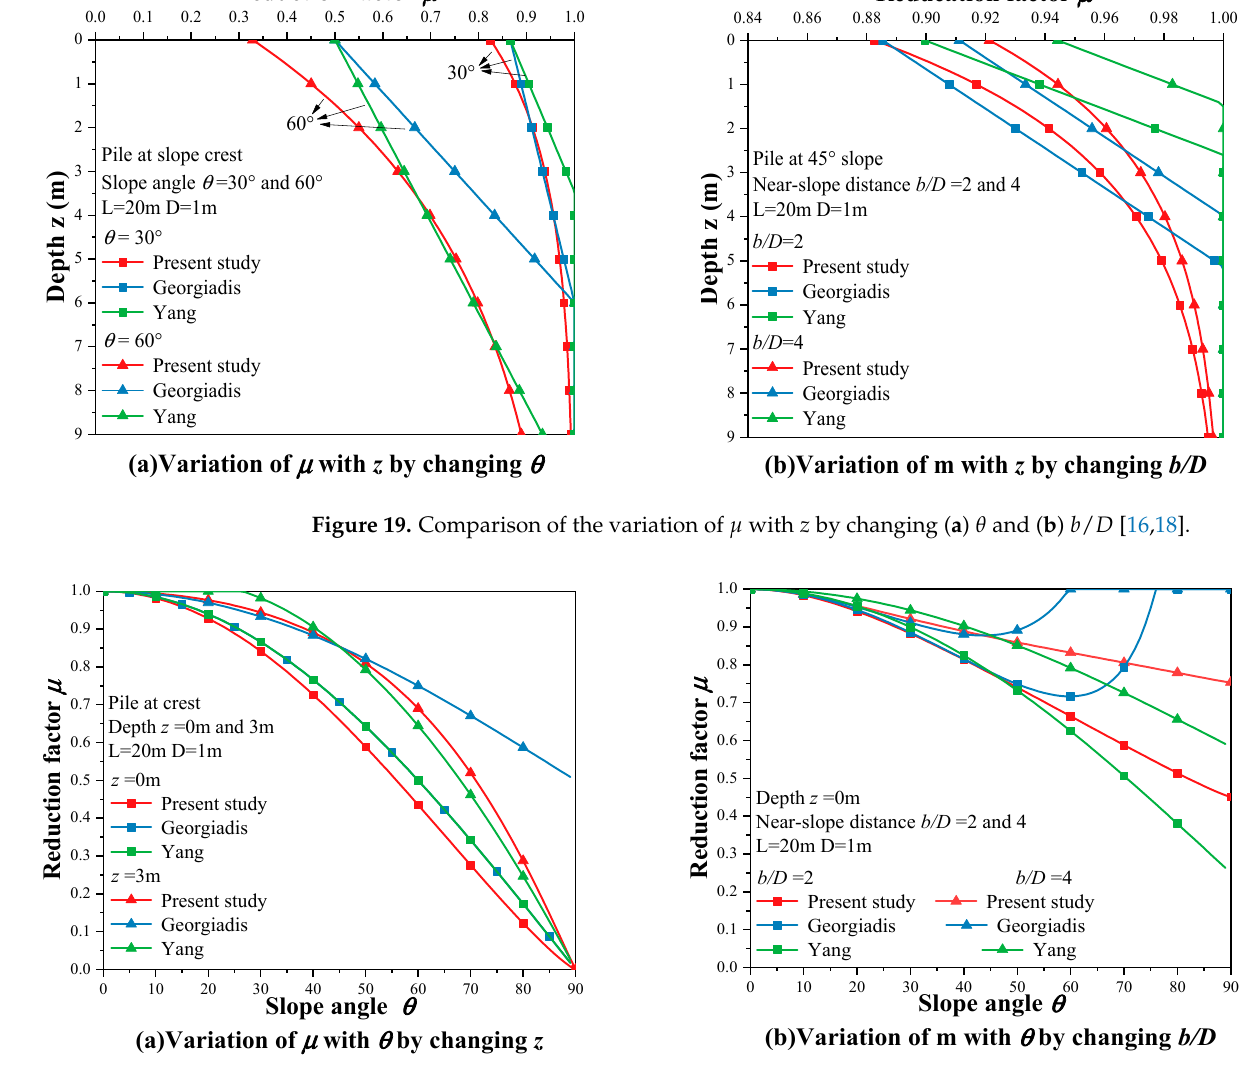
Figure 20. Comparison of the variation of 𝜇 with 𝜃 by changing ( a ) 𝑧 and ( b ) 𝑏/𝐷 [16,18].